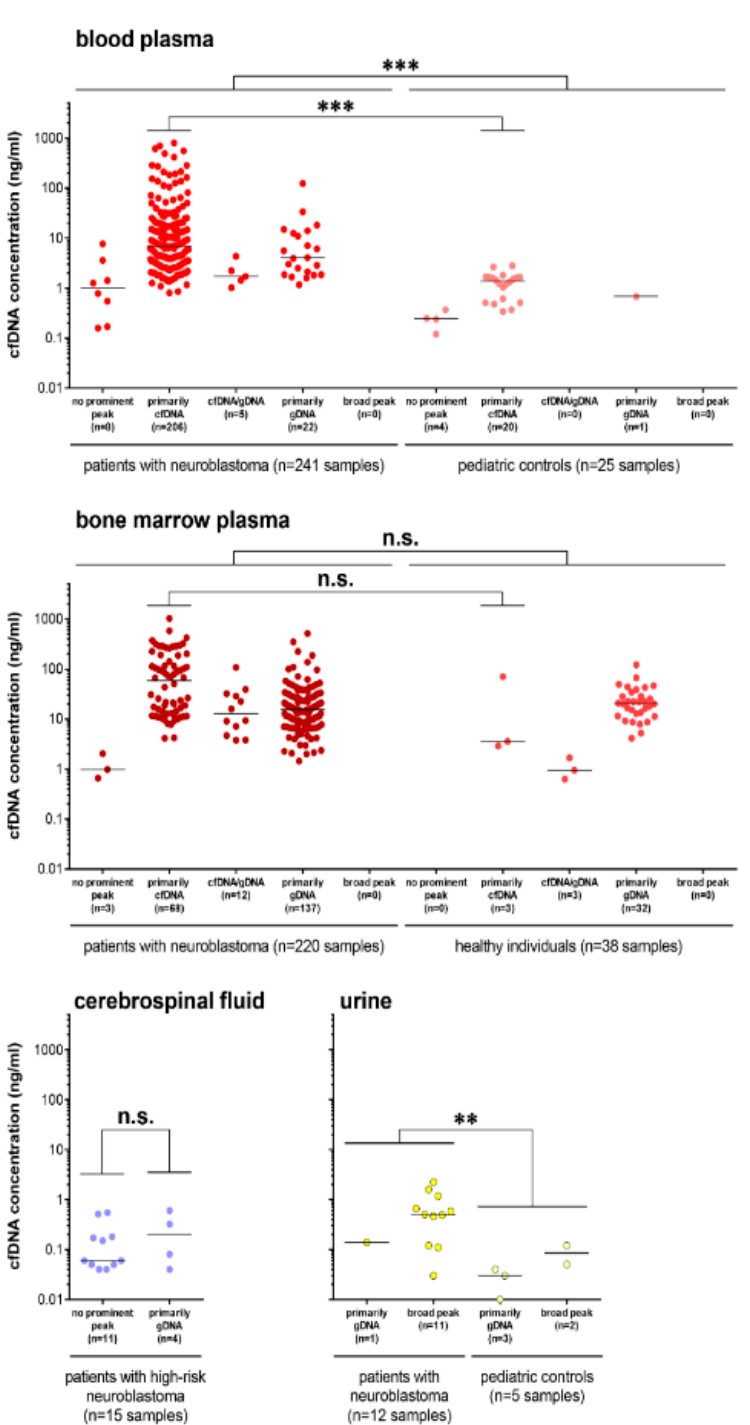
Figure 3. Summary of total cell-free DNA concentrations in biofluids from patients with neuroblastoma and controls. Shown are cfDNA concentrations in blood plasma, bone marrow plasma, cerebrospinal fluid and urine from patients with neuroblastoma and, where applicable, from pediatric controls or healthy individuals. Each symbol depicts an individual measurement. Data are categorized into five different subgroups according to their specific DNA electropherogram. n.s., not significant; ** p ≤ 0.01; *** p ≤ 0.001.